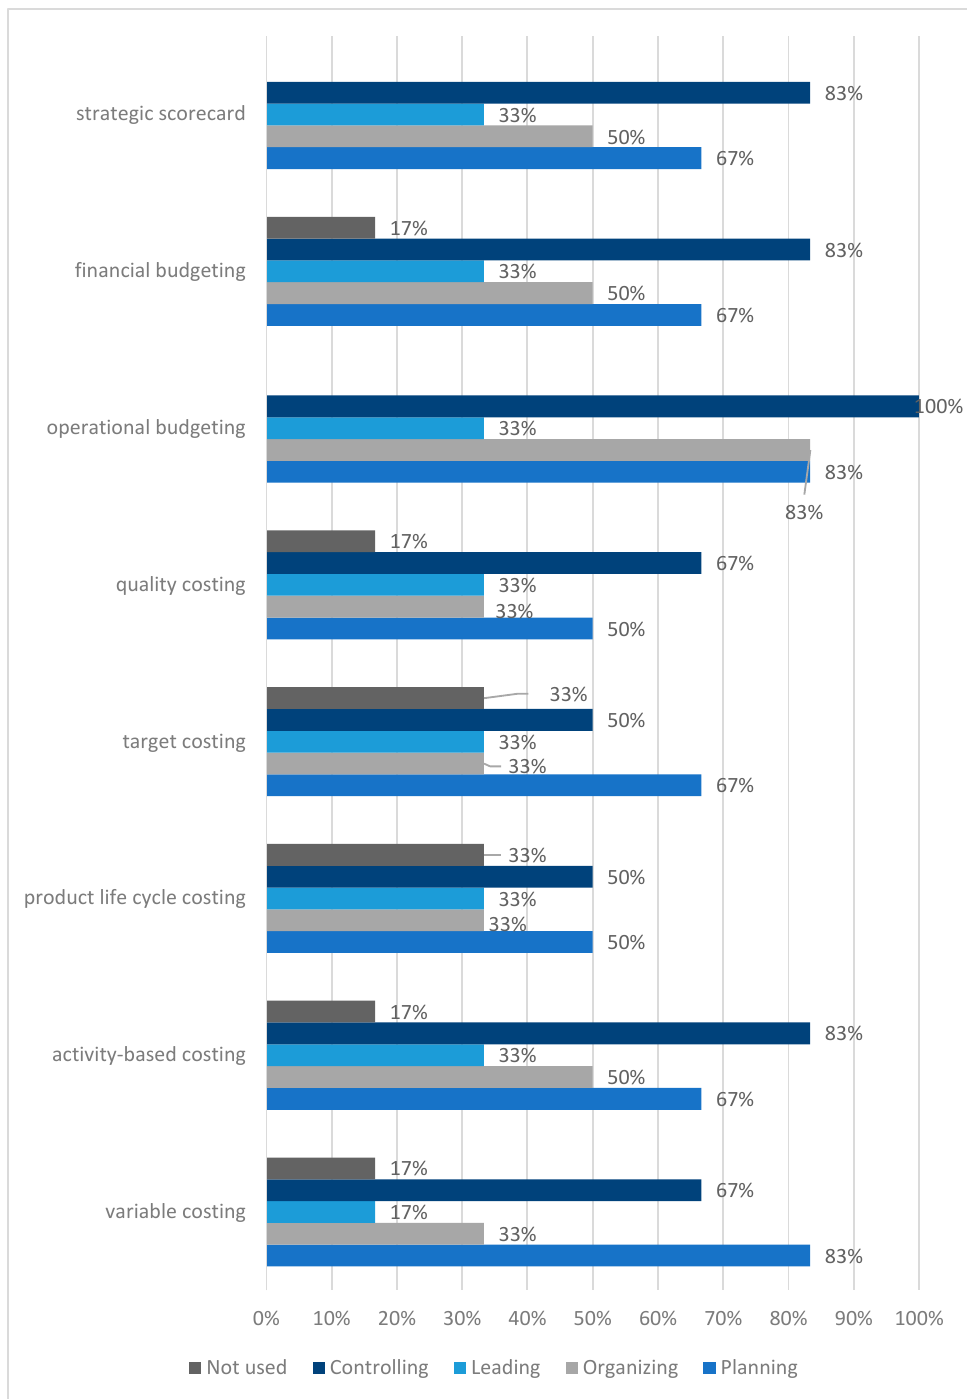
Figure 3. Managerial accounting tools used in the entities surveyed. Source: own elaboration